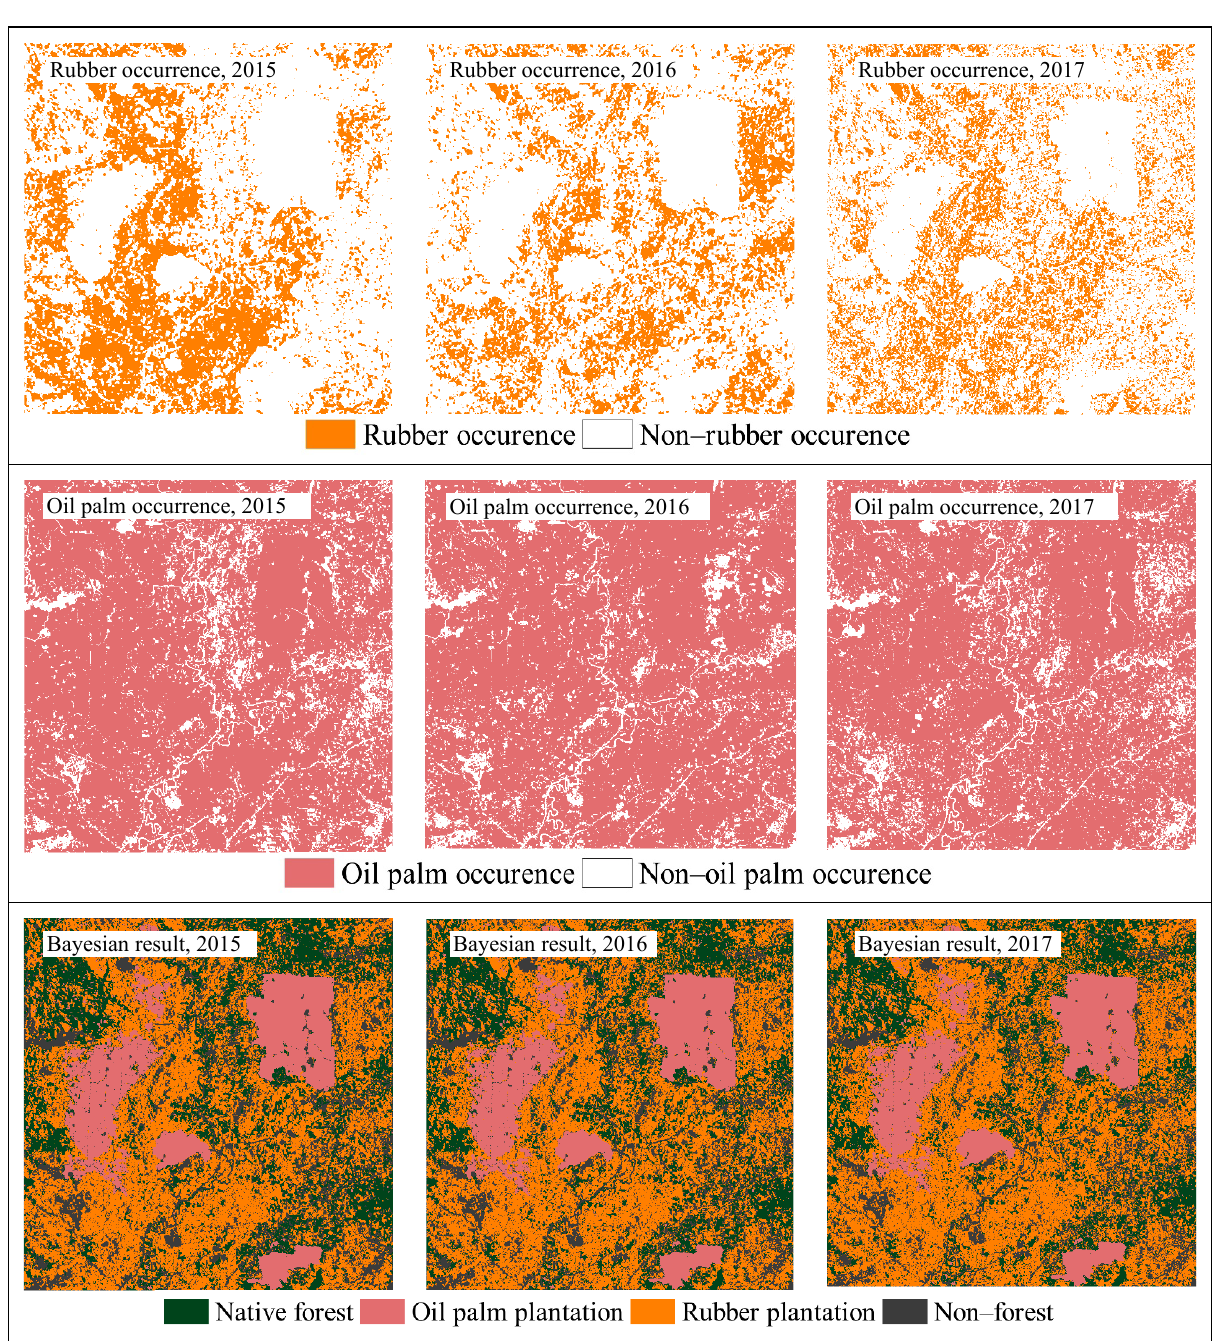
Figure 3. Individual year classification and time series classification images from 2015 to 2017